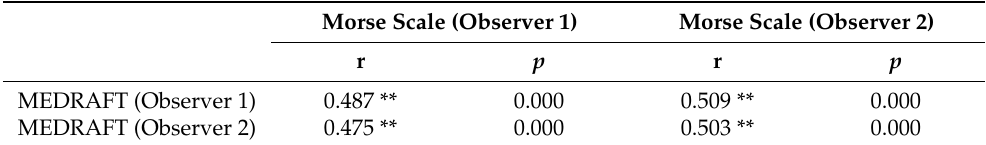
Table 4. Pearson’s correlation between Morse’s scale and MEDFRAT.